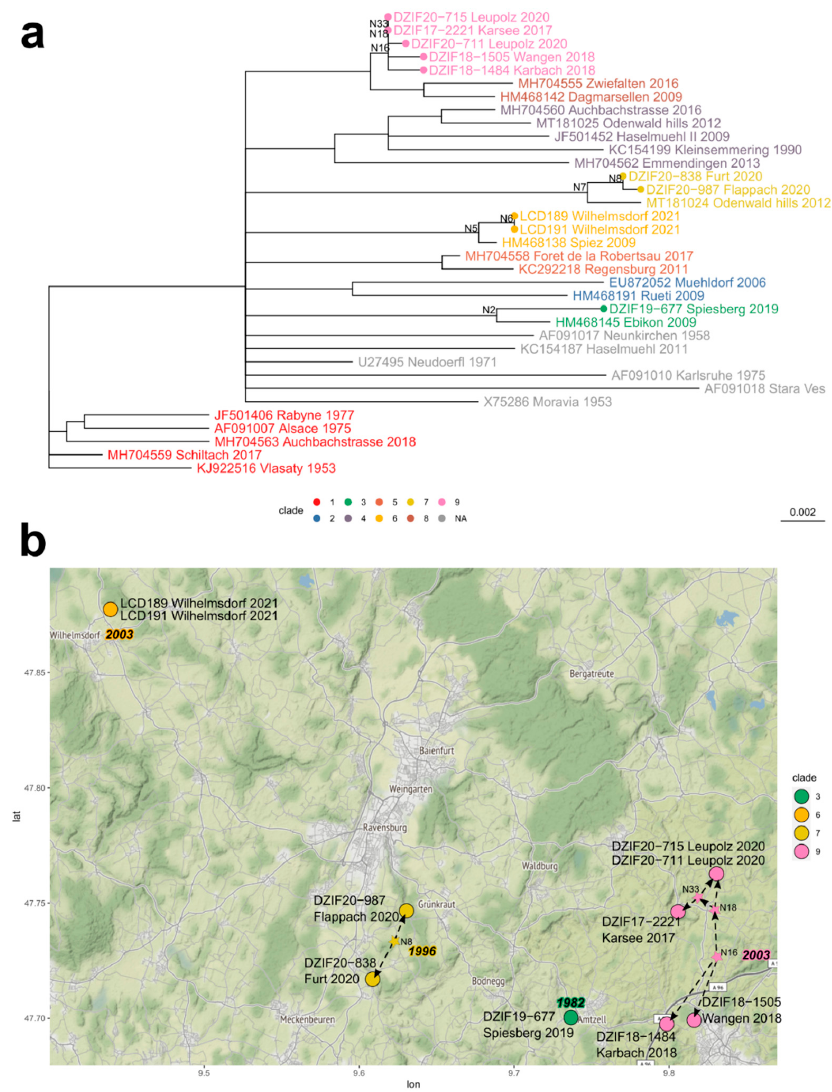
Figure 5. Phylogeography of virus strains from the eight natural TBEV foci in the Ravensburg district. ( a ) Chronogram of the maximum likelihood tree topology of the putative E gene recombination region 1 (see also Figure 1a). Rooted using KJ922516.1 (Vlasaty, CZ, 1953, in clade 1). Divergence times estimated using TreeTime. Internal tree nodes with a bootstrap support below 70% were collapsed. Tip labels are color-coded by evolutionary clade (see color legend). Divergence time estimates of the annotated internal nodes (e.g., N2) are presented in Table 3. The sampled taxa from the eight natural foci of the Ravensburg area are highlighted by node tip points colored by clade. ( b ) Geographical map of the Ravensburg district in Germany. Sampled taxa of the focus areas are color-coded by evolutionary clade. Focus area 1/clade 9: Wangen/Karsee/Karbach/Leupolz; focus area 2/clade 7: Flappach/Furt; focus area 3/clade 6: Wilhelmsdorf; focus area 4/clade 3: Spiesberg. Small stars that connect to the tip points of the sampled isolates via dashed arrow lines and are filled by the same clade color depict putative ancestral states for the two microfoci with multiple isolates. These data points do not represent geographical location but display the microfocus divergence patterns showing the internal dated nodes of the clade in the tree shown in panel 4a. Years given in the color-coded bold font corresponding to each focus represent the estimated divergence dates of the respective clade’s oldest internal node (e.g., clade 7/focus 2: node N7: 1996). Thus, these dates represent the maximum age of the clade and upper boundary for the emergence of the respective TBEV focus